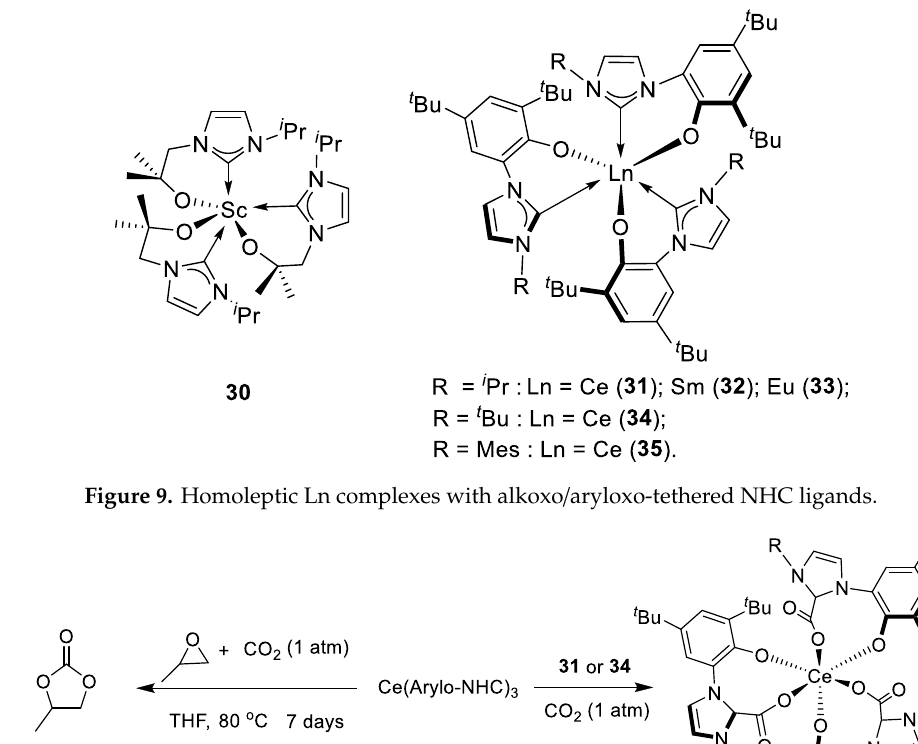
Figure 8. The Y and Ti complexes bearing heteroatom-tethered NHC ligands used for ring-opening polymerization (ROP) of lactide.